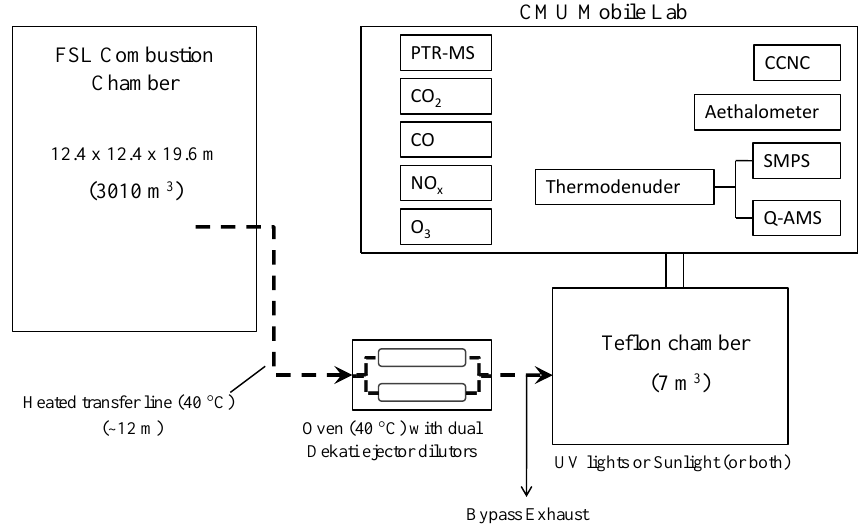
Fig. 1. Schematic of experimental setup used for the photo-oxidation experiments (not drawn to scale).